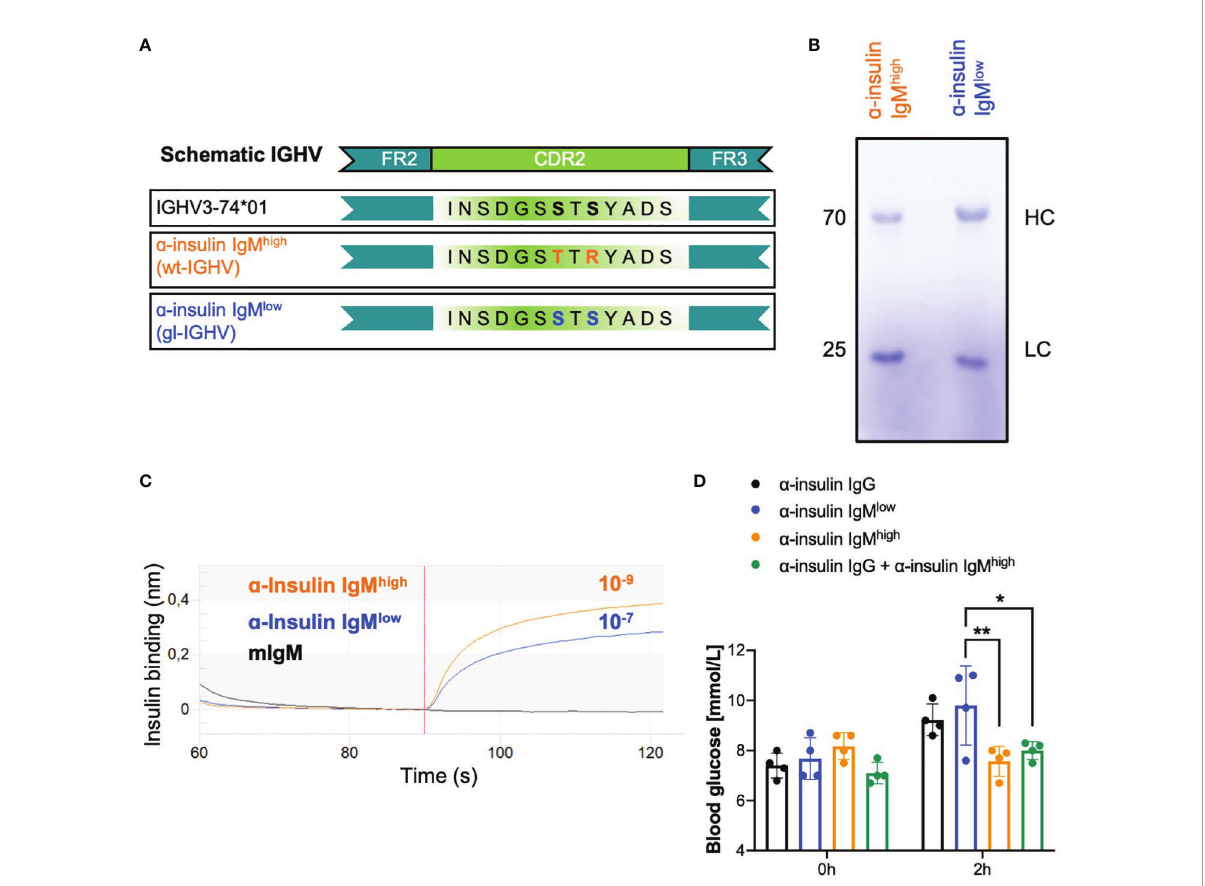
FIGURE 1 Recombinant low af fi nity anti-insulin IgM neutralizes insulin in vivo. (A) Schematic representation of the recombinant in-house puri fi ed anti-insulin IGHV highlighting the two mutations in the CDR2 which were reverted to the germline version of the IGHV3-74*01 allele. Orange: a -insulin IgM high (WT- IGHV); blue: a -insulin IgM low (gl-IGHV). (B) Coomassie-blue stained SDS-PAGE showing puri fi ed a -insulin IgM high and a -insulin IgM low under reducing conditions (with b -mercaptoethanol). The image is representative of three independent experiments. (C) Insulin-binding af fi nity of a -insulin IgM high and a -insulin IgM low measured by bio-layer interferometry. K D (dissociation constant) was calculated by the software. The experiment shown is representative of 3 independent experiments. (D) Blood glucose concentrations of WT mice intravenously (i.v.) injected with 100 µg a -insulin IgG (black bar, n = 4), a -insulin IgM low (blue bar, n = 4), a -insulin IgM high (orange bar, n = 4) or a -insulin IgG + a -insulin IgM high (n = 4, green bar) measured at indicated time points. Mean ± SD, statistical signi fi cance was calculated using two-way ANOVA with Sidak ’ s multiple comparisons test. *p < 0,05; **p <